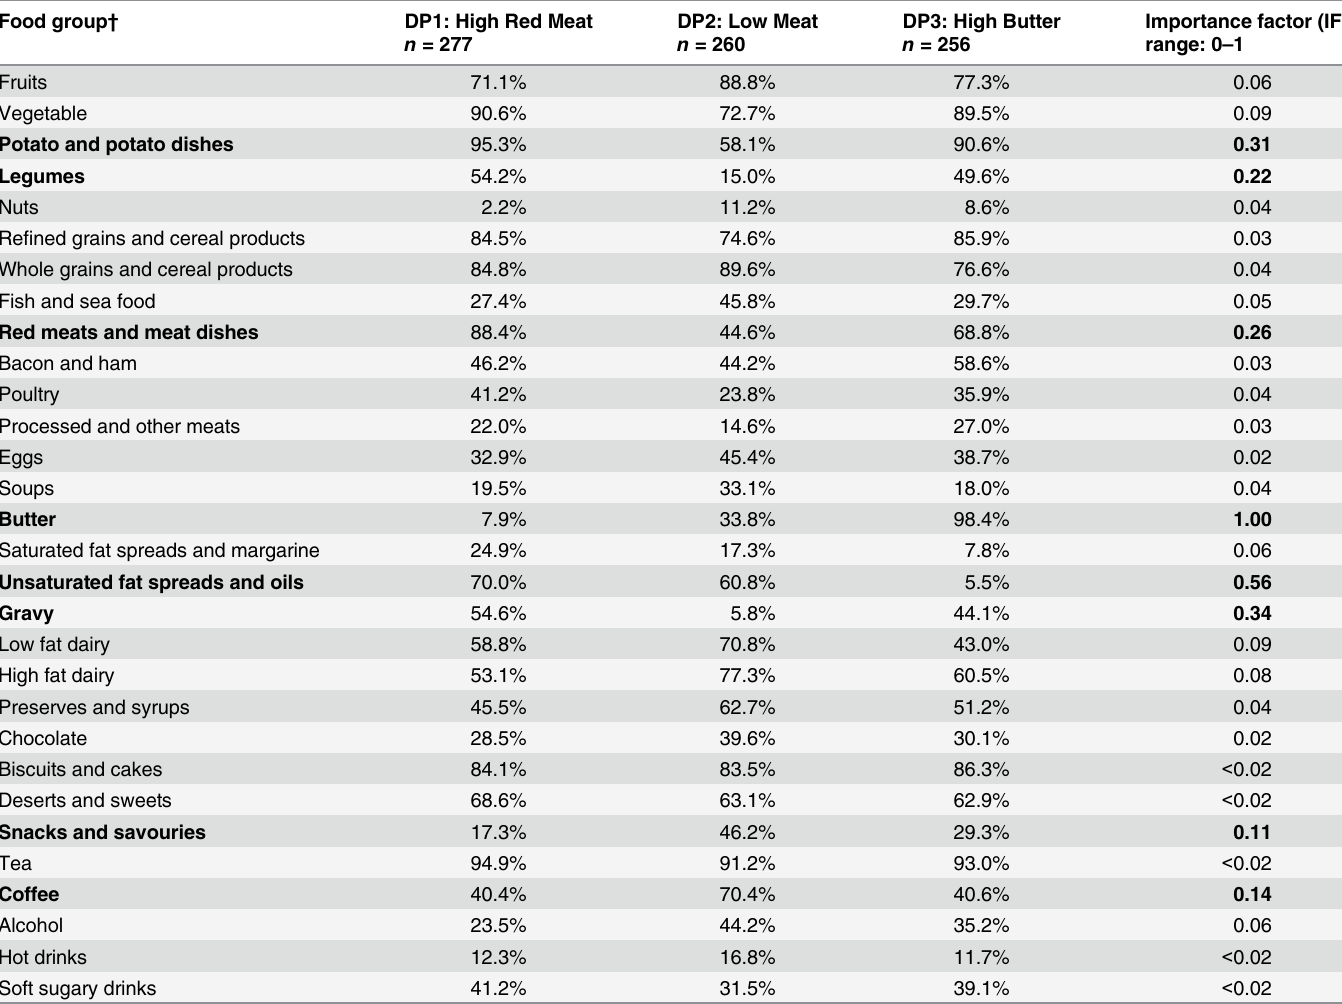
Table 1. Percentages of participants consuming each of 30 food groups by dietary pattern (DP) with importance factor * .